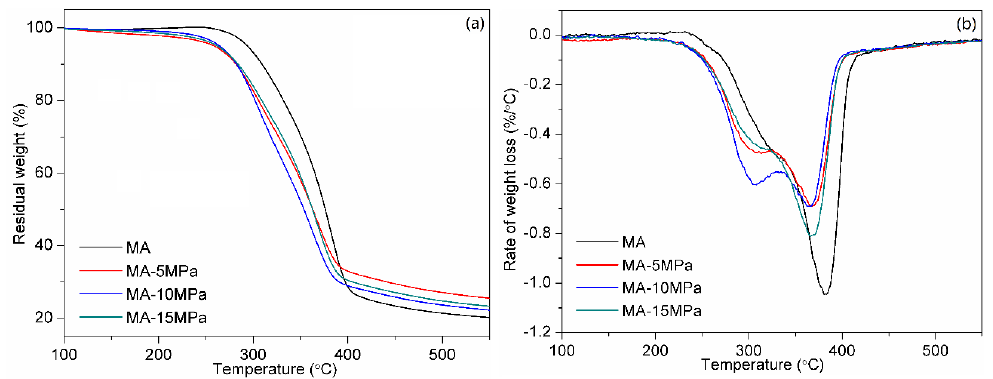
Figure 5. ( a ) Thermogravimetric (TG) and ( b ) derivative thermogravimetric (DTG) curves of the MA sample and the all-wood biocomposites with different hot-pressing pressures.